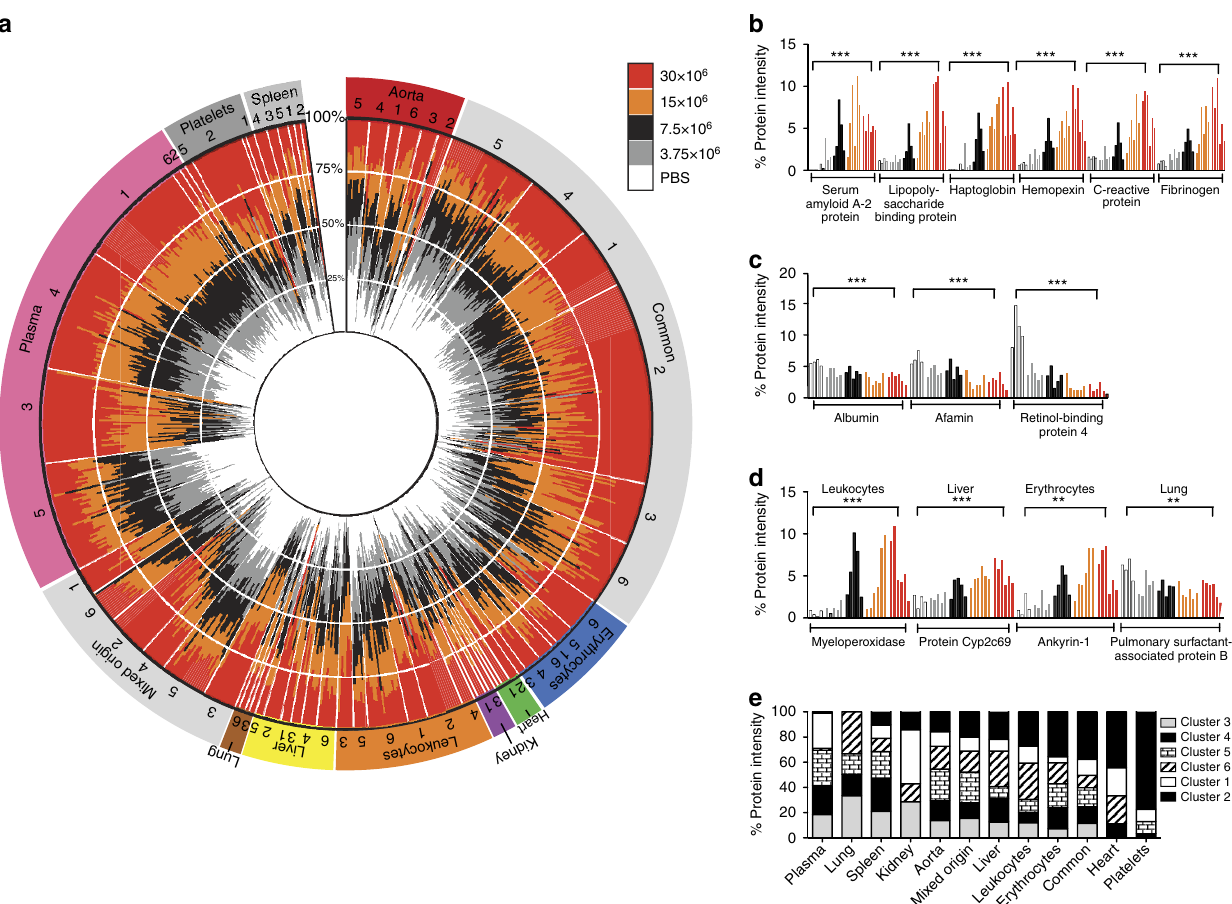
Figure 5 | Sepsis results in increasing tissue-specific proteins in the blood plasma. The previously defined organ-, cell- and plasma-associated proteins identified in blood plasma using DIA was overlaid the t-SNE clusters. ( a ) Polar histogram illustrating quantitative protein changes of the defined tissue-, cell- and plasma-associated proteins across the five dose groups. The individual proteins are shown as bar plots and protein distribution coloured according to the dose group. The bar plots are shown in a circular polar histogram arranged in the same way as in Fig. 3a. The annotation outside the circle represents most likely organ, plasma and cell origin. The outer circle represents the proteins proposed primary localization defined by Fig. 3a and the clusters defined in Fig. 4b. The inner circle displays changes in protein abundance across the different dose groups. ( b , c ) Proteins increase or decrease in a dose-dependent fashion. ( d ) Examples of tissue proteins shown in Fig. 3c. ( e ) Total intensity of the organ, plasma and cell-specific associated proteins for every t-SNE clusters. Proteins were compared between untreated and the highest bacterial load and was evaluated by Student’s t -test. The multiple-testing corrected (Hochberg) P values were calculated on the basis of a two-tailed distribution and unequal variance. * P o 0.05, ** P o 0.01, *** P o